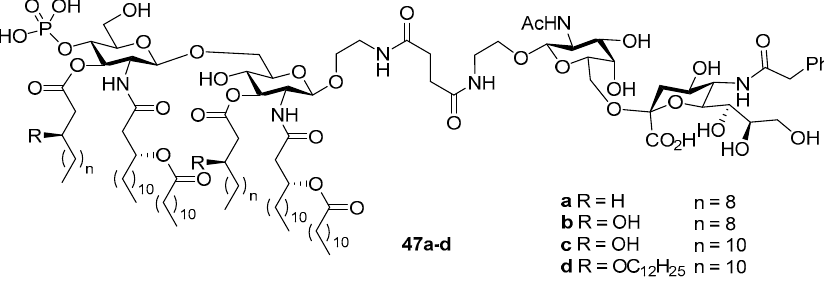
Figure 2. Conjugates of sTn antigen with MPLAs containing different lipid structures for SAR studies.